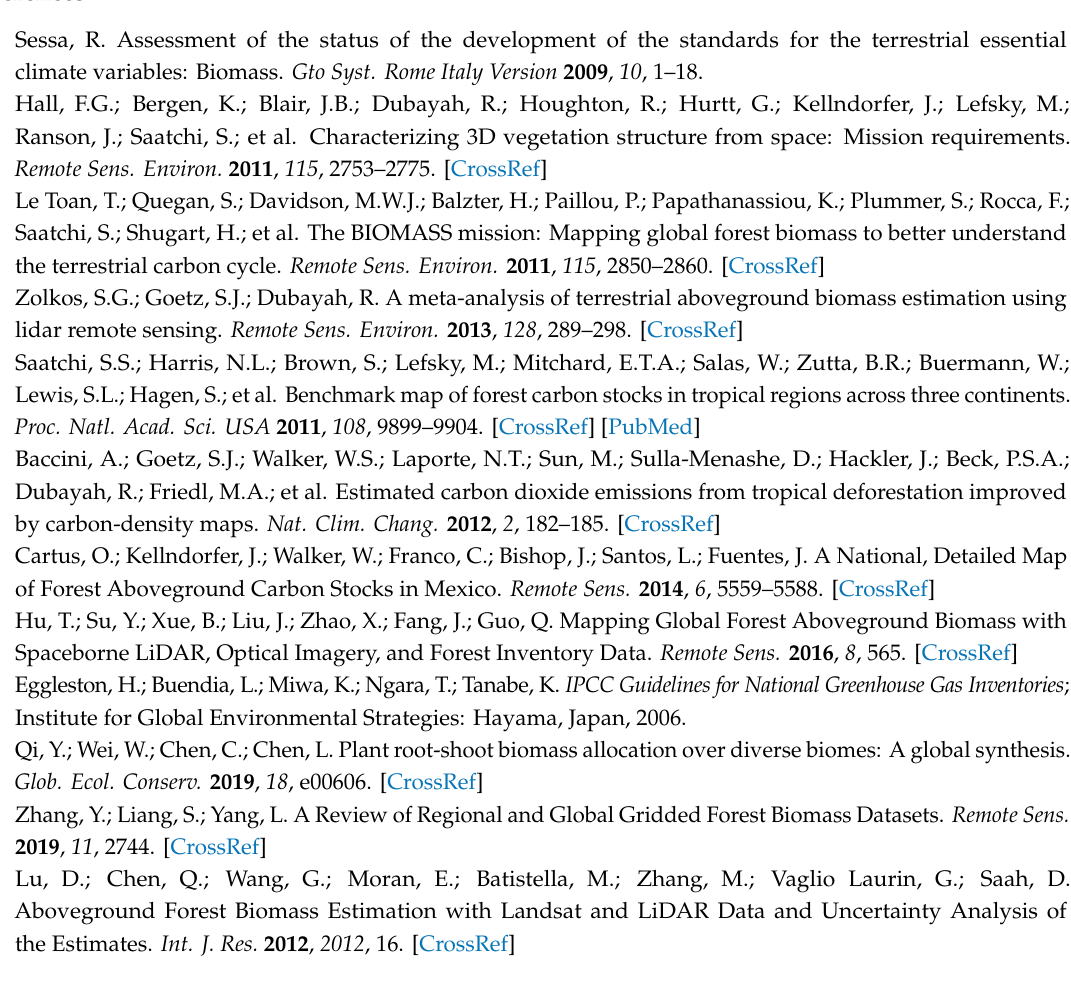
Figure S1: feature importance values for the predictor variables in the eight machine learning regression algorithms under the stratified sampling scenario, Figure S2: feature importance values for the predictor variables in the eight machine learning regression algorithms under the separate modeling scenario, Figure S3: density scatter plot of the predicted AGB values generated by simply combining the results of the MARS, SVR, RF, ERT, GBRT, SGB, CatBoost, and MLP algorithms for 50 runs under the random sampling scenario, Figure S4: residual analysis of the di ff erent modeling results that were obtained by simply combining the predictions of the MARS, SVR, RF, ERT, GBRT, SGB, CatBoost, and MLP algorithms for 50 runs under the random sampling scenario. Author Contributions: Y.Z. conceived the study; Y.Z. and J.M. performed the data analysis; Y.Z., J.M., S.L., X.L., the